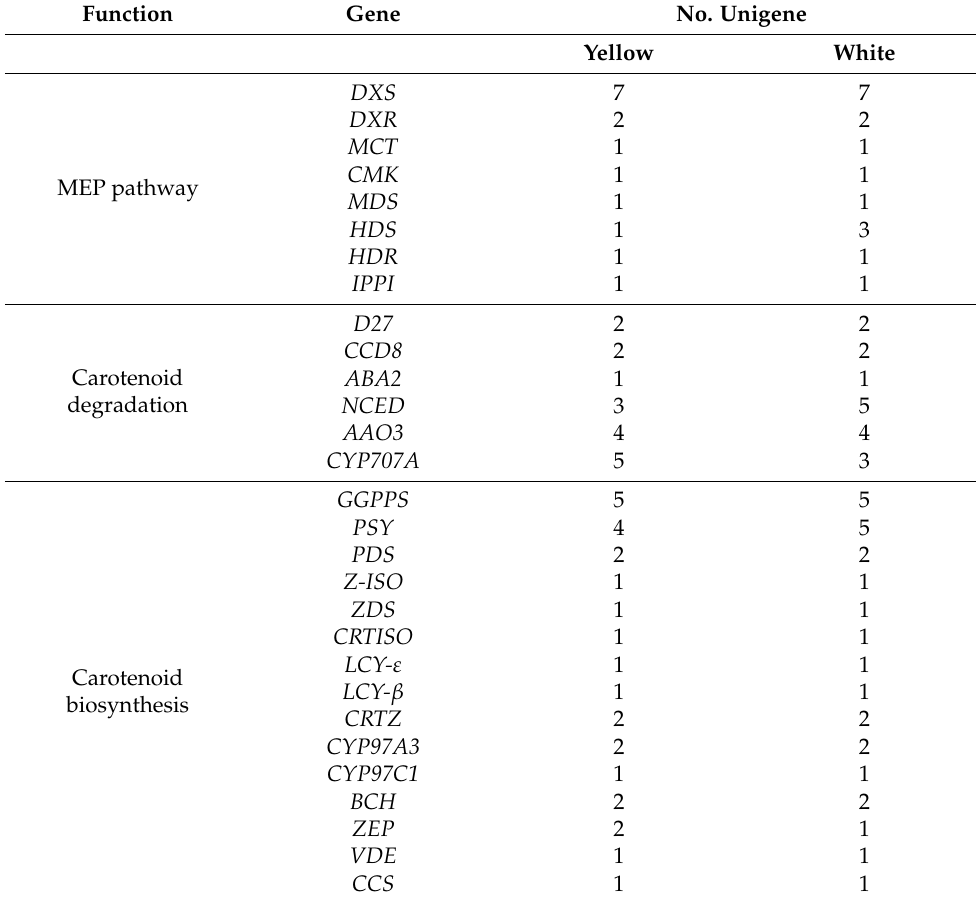
Table 3. The number of unigenes related to carotenoids metabolic pathway in Chinese narcissus. Function Gene No. Unigene Yellow White